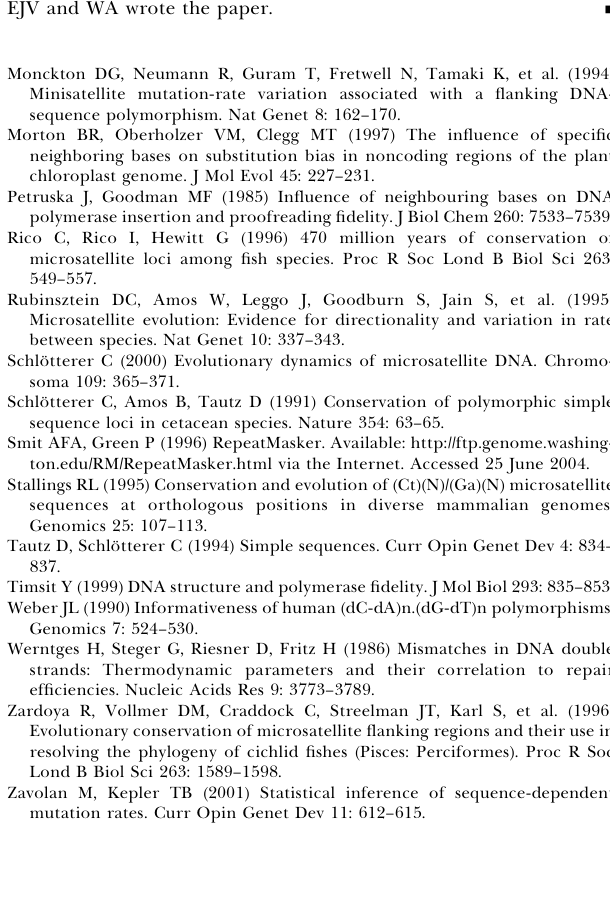
satellites, are shown by a black line in (A) and (C), and (B) and (D), respectively. Average percentage match rather than average match is plotted in (B) and (D) because overlapping blocks were truncated to exclude overlapping regions from the analysis, with the result that not all blocks contained 20 bases. Figure S5. Mean Proportion of Mismatches along Homologous Flanking Sequences The proportion of mismatches occurring at a given base in a flanking sequence are averaged over (AC) 2–3 microsatellite loci (A) and over (AC) 4 þ microsatellite loci (B). Shown 6 standard error. The micro- satellite at base position 0 is not shown. Expectation, calculated separately for 5 9 and 3 9 sequences around (AC) 2–3 microsatellites, is shown by a black line in both plots. Found at DOI: 10.1371/journal.pbio.0020199.sg005 (3.4 MB